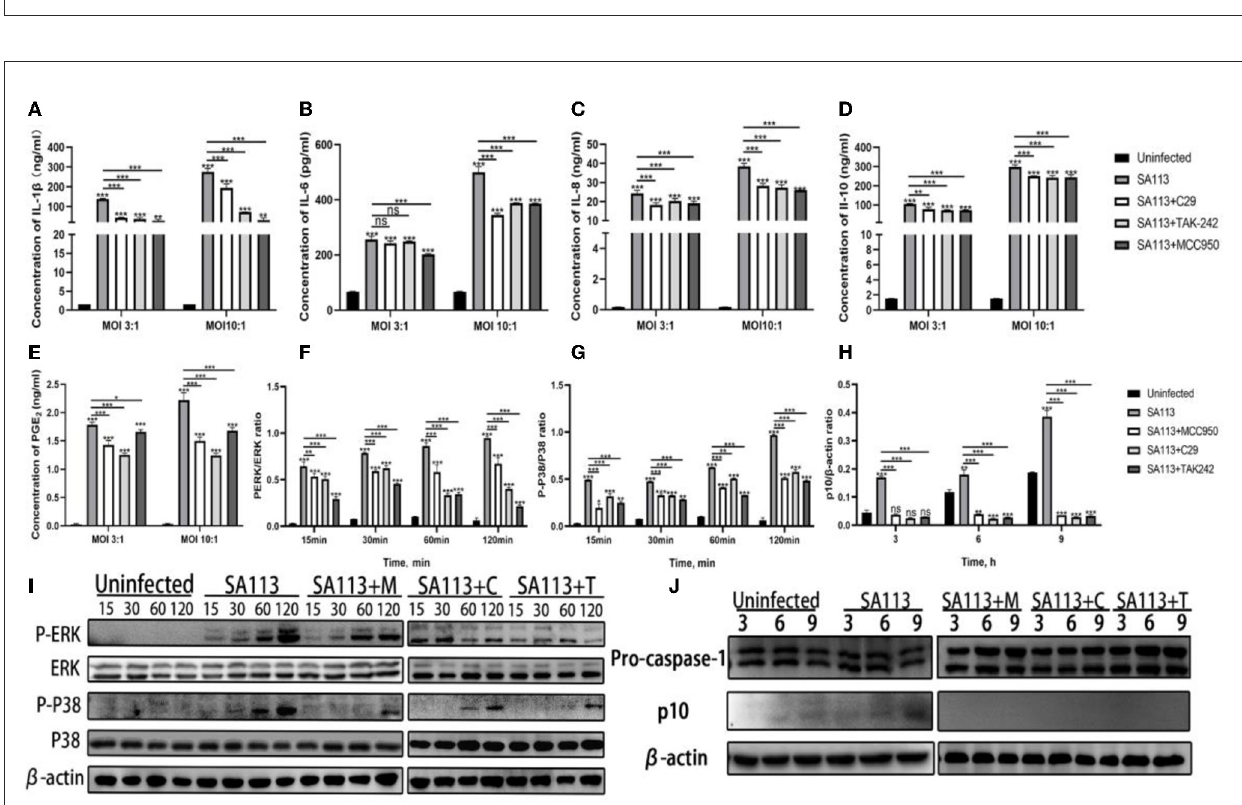
FIGURE3 The secretion of PGE 2 and cytokines mediated by neutrophils depends on TLR2, TLR4, and NLRP3 receptors. ELISA results showed the secretion levels of cytokines IL-1 β (A) , IL-6 (B) , IL-8 (C) , IL-10 (D) , and PGE2 (E) in the SA113, C29, TAK-242, and MCC950 groups after neutrophils infection with MOI 3:1 and MOI 10:1. Western blot analysis revealed the activation of the MAPK (F, G, I) and Caspase-1 (H, J) signaling pathways. ns P > 0.05, * P < 0.05; ** P < 0.01; *** P <